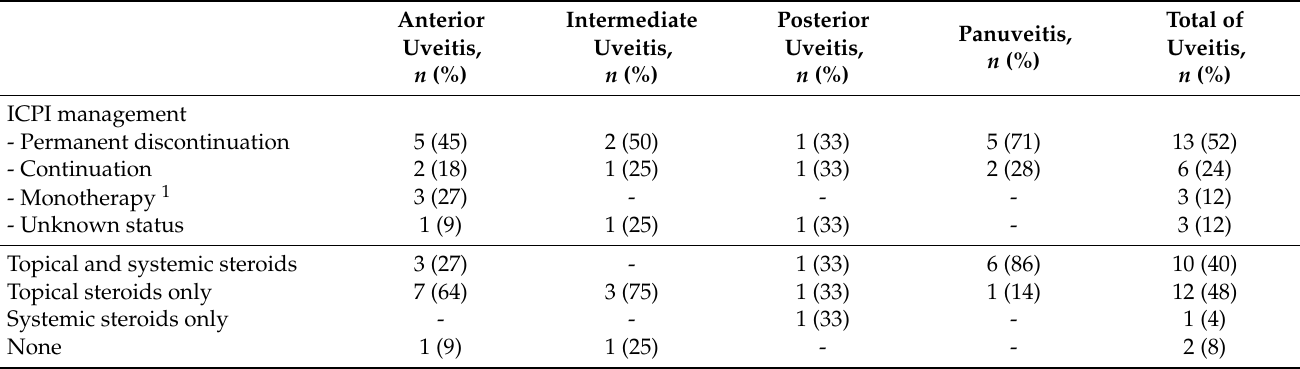
Table 6. Management of ICPI-induced uveitis.